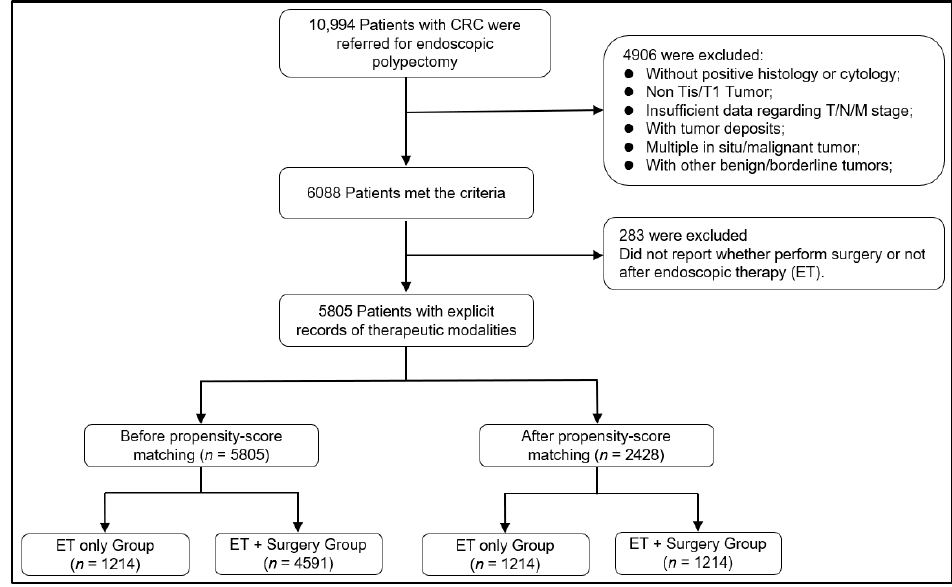
Figure 1. Flow chart of study enrollment and exclusions.